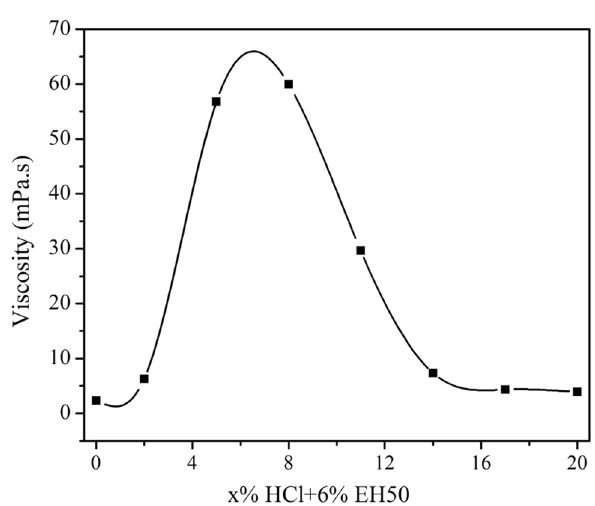
Fig. 2 Influences of concentration of HCl for apparent viscosity of diverting